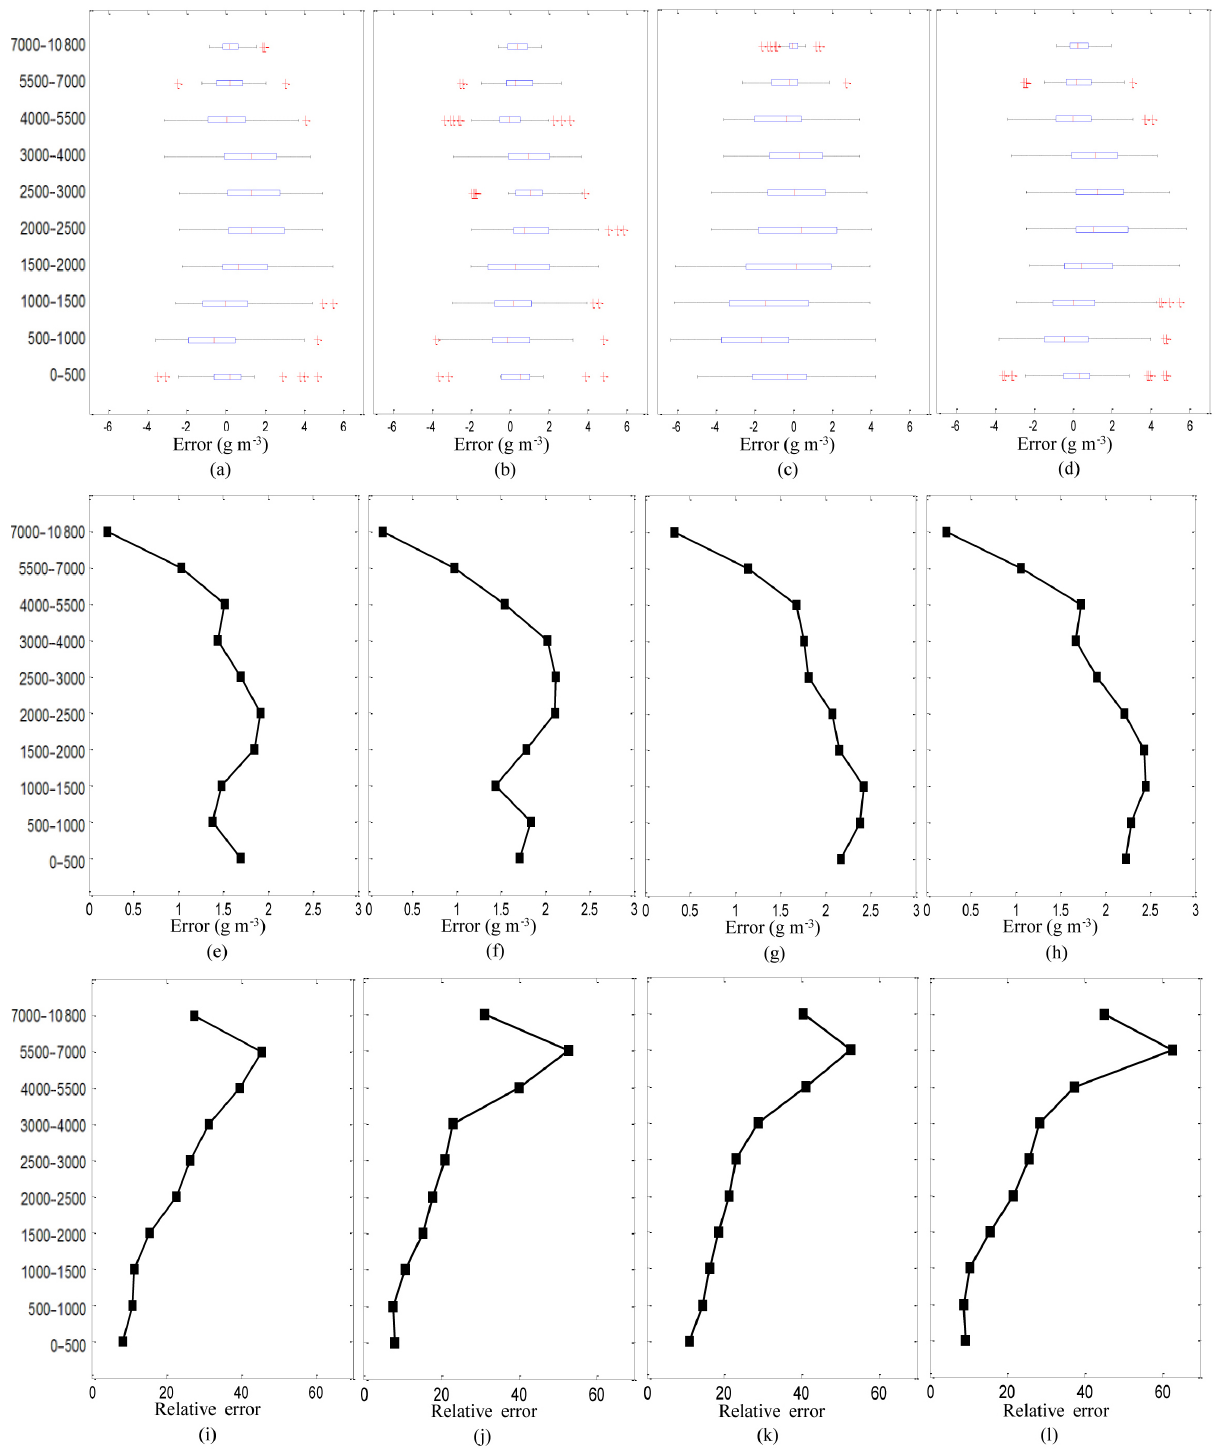
Figure 6. Statistics of the humidity differences between tomographic solutions and radiosonde data in each layer from DOY 221 to 227 2015. (a–d) Box plots, (e–h) RMSE, and (i–l) relative error of the humidity difference in 10 layers using 4nodes, 8nodes, 12nodes, and constant